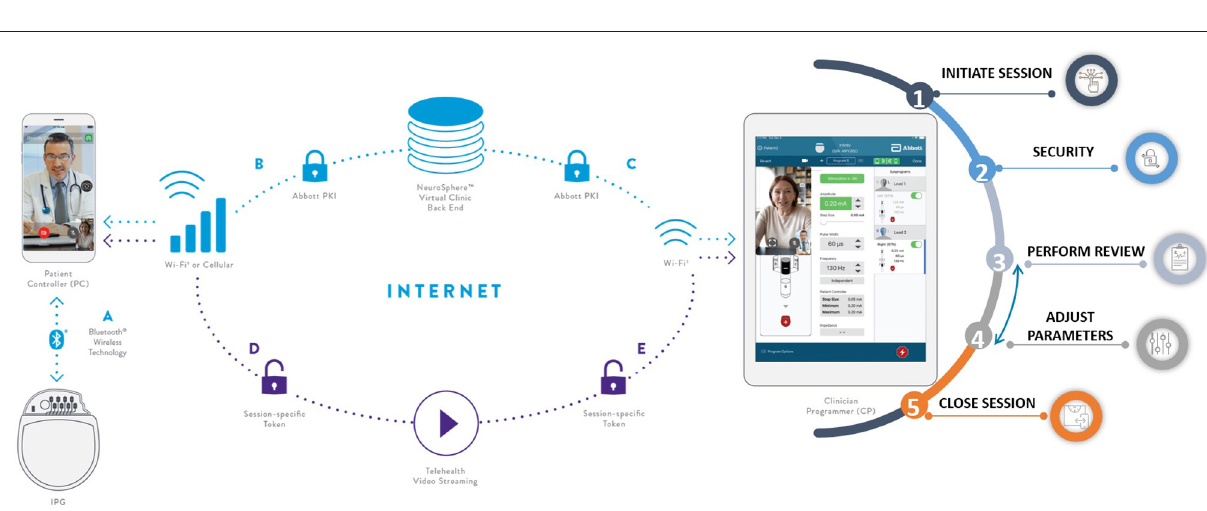
but it can be significantly higher (tens of microvolts) when recorded from the cortex using electrode strips (91). In ranges from 500 Hz to 5 kHz, the LFPs frequency band is 2–100 Hz, quite similar to common electroencephalography ( Figure 6